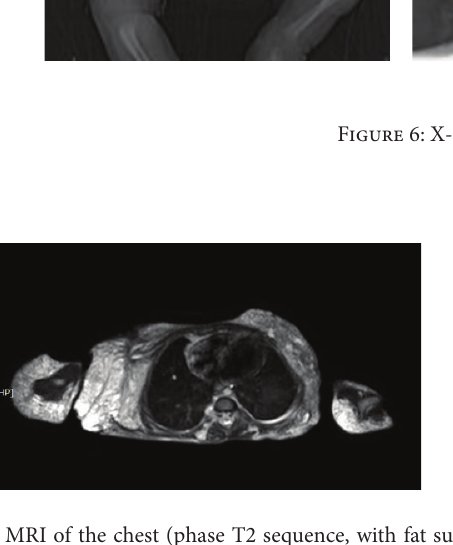
Figure 7: MRI of the chest (phase T2 sequence, with fat suppres- sion), showed the lymphangioma in the upper part of the chest wall, in the right